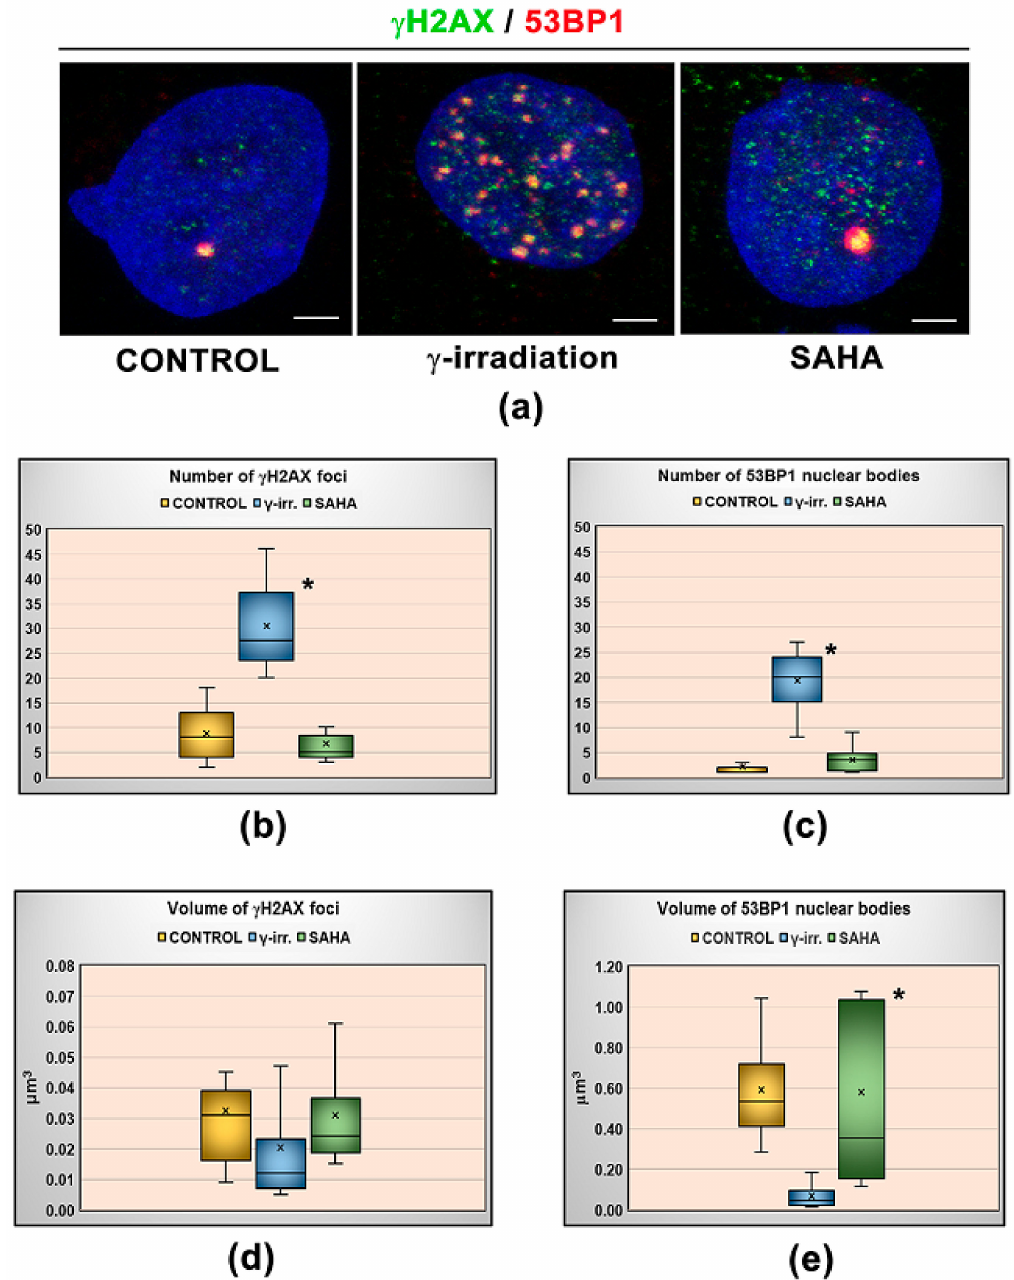
Figure 6. Nuclear distribution pattern of 53BP1 foci and phosphorylated histone H2AX. ( a ) Close proximity or co-localization between 53BP1 foci (red) and phosphorylated histone H2AX ( γ H2AX, green) in control, γ -irradiated (5 Gy) and SAHA (15 µ M) treated human cervix adenocarcinoma (HeLa) cells. Cells were harvested 2 h after the treatment. Scale bars show 5 µ m. Irradiation by γ -rays increased the number of ( b ) γ H2AX and ( c ) 53BP1-positive foci. ( d ) The volume of γ H2AX foci in control, γ -irradiated (5 Gy) and SAHA (15 µ M) treated cells remain unchanged. ( e ) SAHA treatment enlarged the volume of 53BP1-positive foci, as indicated by asterisk showing a large scale of 53BP1-foci volume. Irradiation by γ -rays reduced the number of 53BP1-positive foci (blue box). Immunofluorescent data were quantified using the ImageJ software. Fifty cell nuclei per sample were studied. The box plots are displaying the distribution of data based on the summary of five numbers: minimum, first quartile, median, third quartile, and maximum. Asterisks show significantly di ff erent results from control values, at p ≤ 0.05. Student’s t-test was used for data